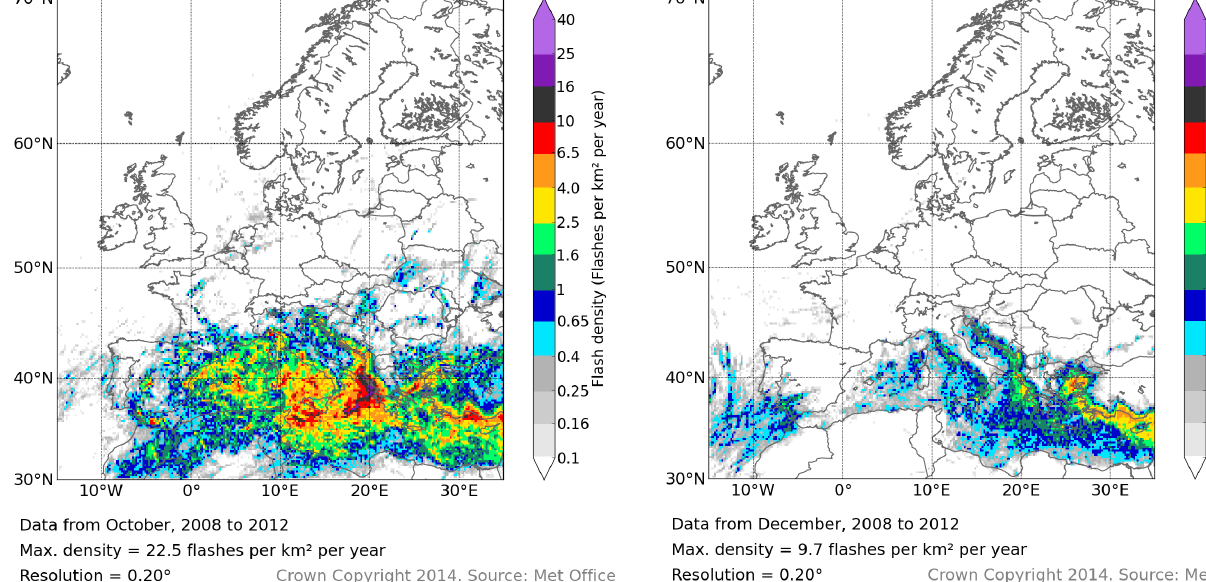
Fig. 16. Detected lightning flash density for